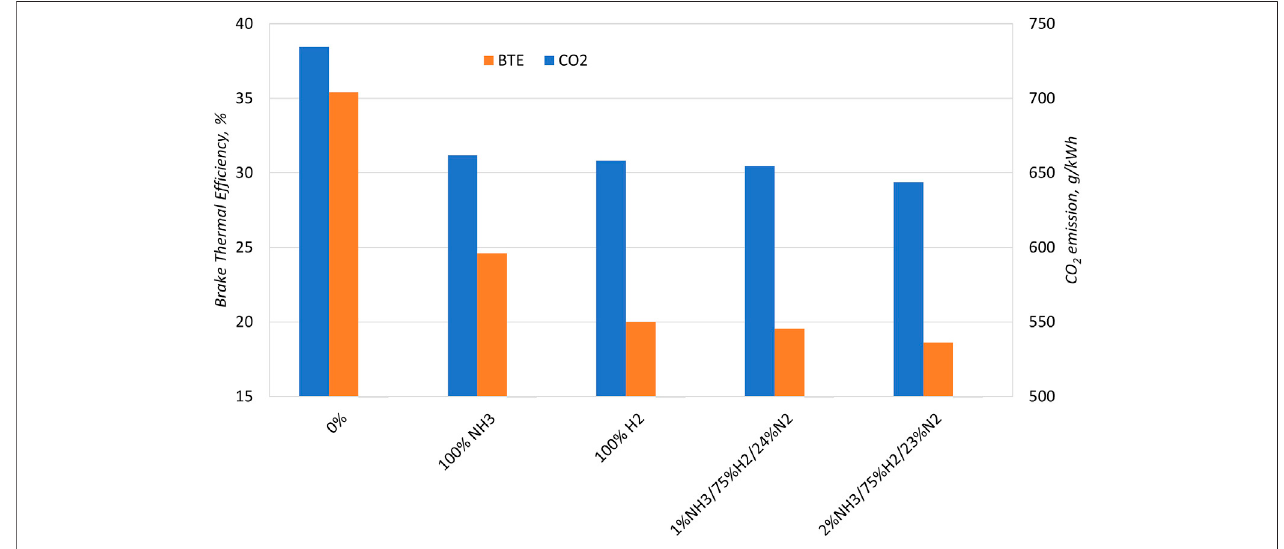
FIGURE 7 | Brake thermal ef fi ciency for different intake air additives: gaseous ammonia, pure hydrogen, and dissociated ammonia (Gill et al., 2012).